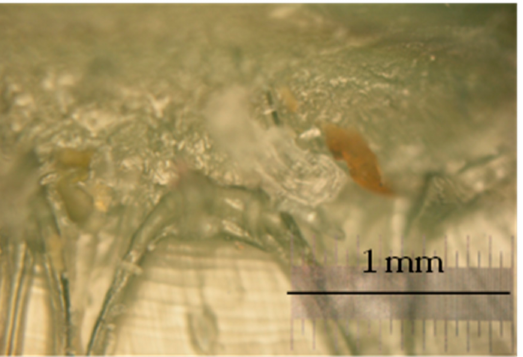
Figure 7. Scar after the ballistic test—transparency of the material is lost and there are visible copper particles.